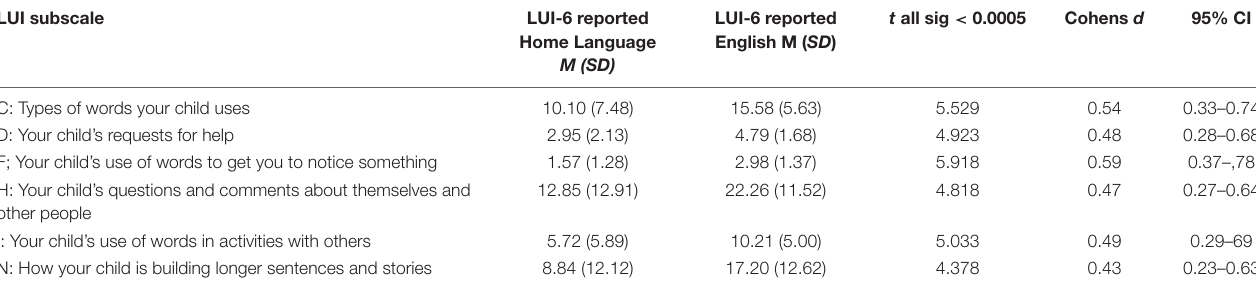
TABLE 7 | Comparison between scores for LUI-6 subscales when reported for English language use and home language use for the same child. LUI subscale